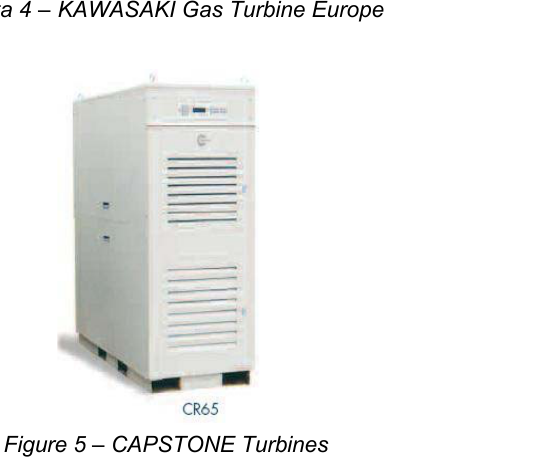
Figure 5 – CAPSTONE Turbines Рис . 5 – CAPSTONE Turbines Слика 5 – CAPSTONE